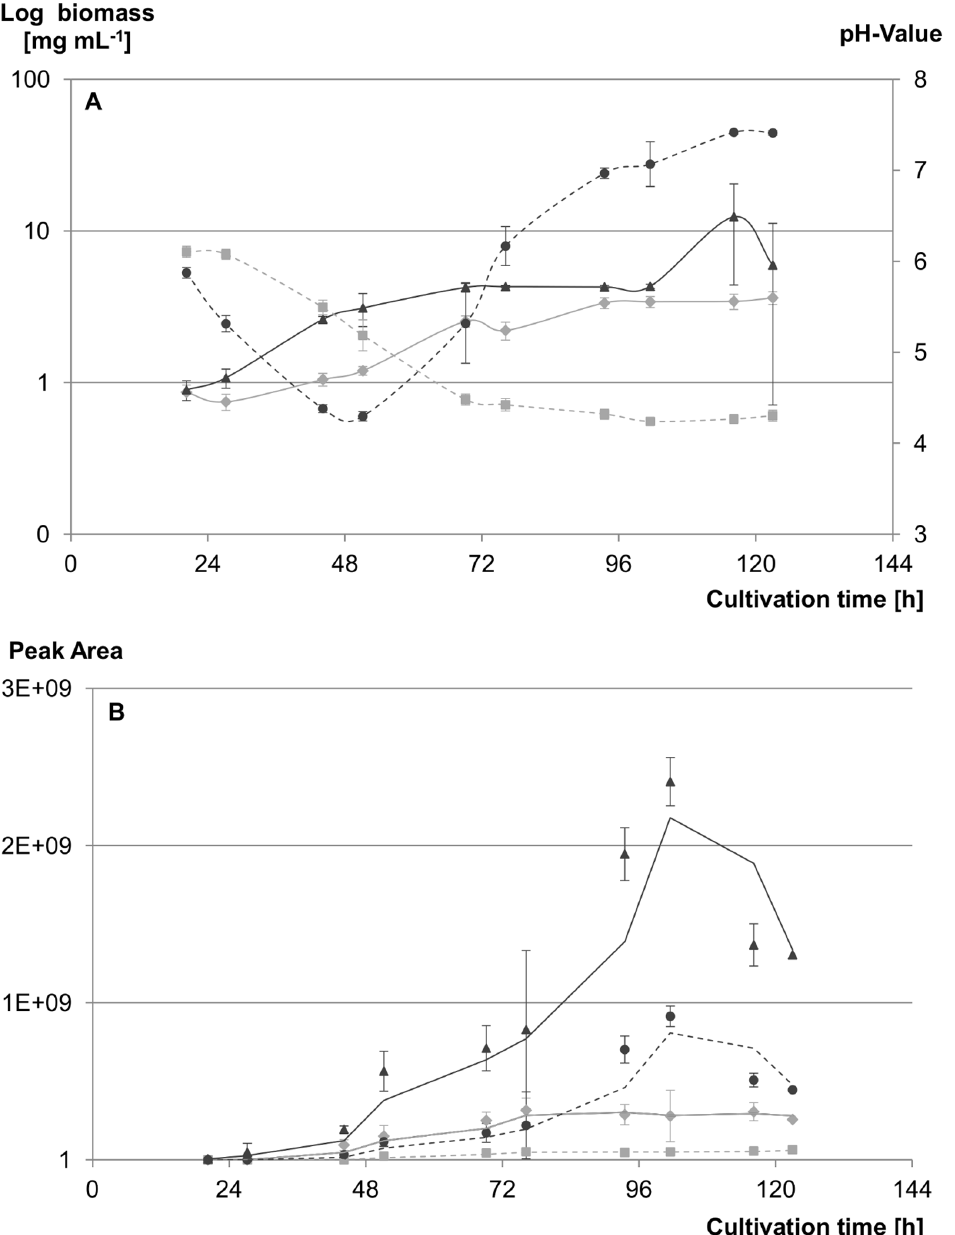
Fig 1. Comparative growth curves of LF580 and LF580-M26. (A) Time series of the biomass (LF580: — ◆ — (light grey); LF580-M26: — ▲ — (dark grey)) and pH value (LF580: -- ■ -- (light grey); LF580-M26: -- ● -- (dark grey)) for the wild type strain LF580 and its mutant strain LF580-M26 are shown. Determinations were performed in triplicates for 6 days. (B) Production levels of scopularide A (LF580: — ◆ — (light grey); LF580-M26: — ▲ — (dark grey)) and B (LF580: -- ■ -- (light grey); LF580-M26: -- ● -- (dark grey)) during the time series are compared on the basis of the peak area of the respective mass signal after analytical HPLC-MS. The curves represent the trend